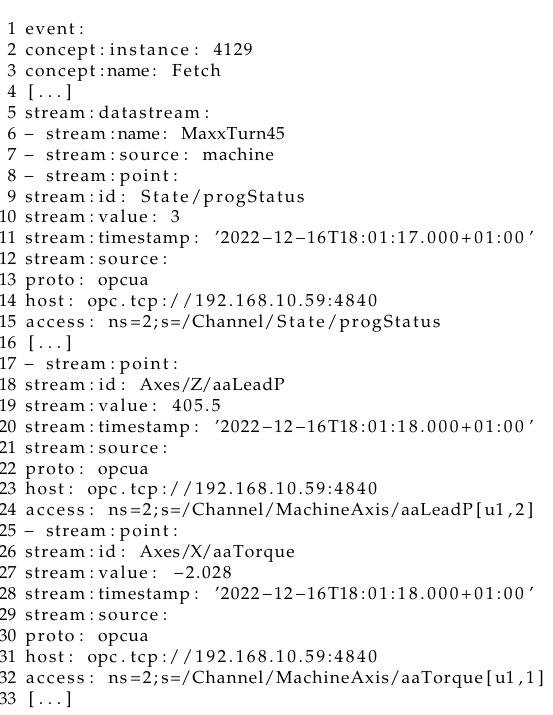
Figure 8. One Good and One Bad (With Chip) Chess Piece on the Palette (Figure available at https://doi.org/10.5281/zenodo.7477845 (accessed on 8 February 2023)). Listing 8. Chess Piece Machining